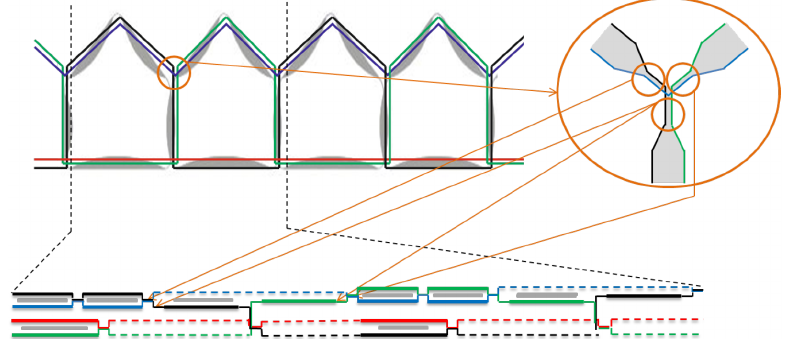
Figure 12. Transfer of compliant sections into 2D weaving arrangement for textile manufacturing of a PACS cantilever (weave: —, float: - - -)